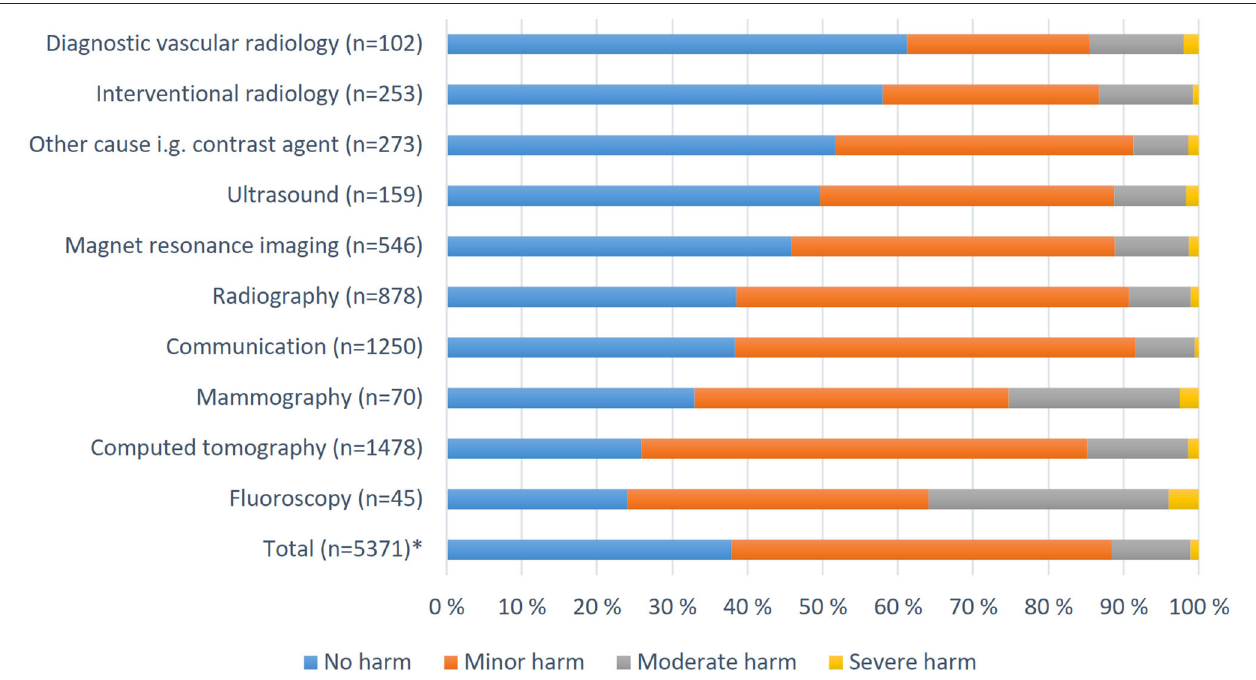
FIGURE 3 | Patient injuries assessed by supervisors in different modalities and other contexts in Finland 2010–2017. *Missing or unknown 26.3% ( n =